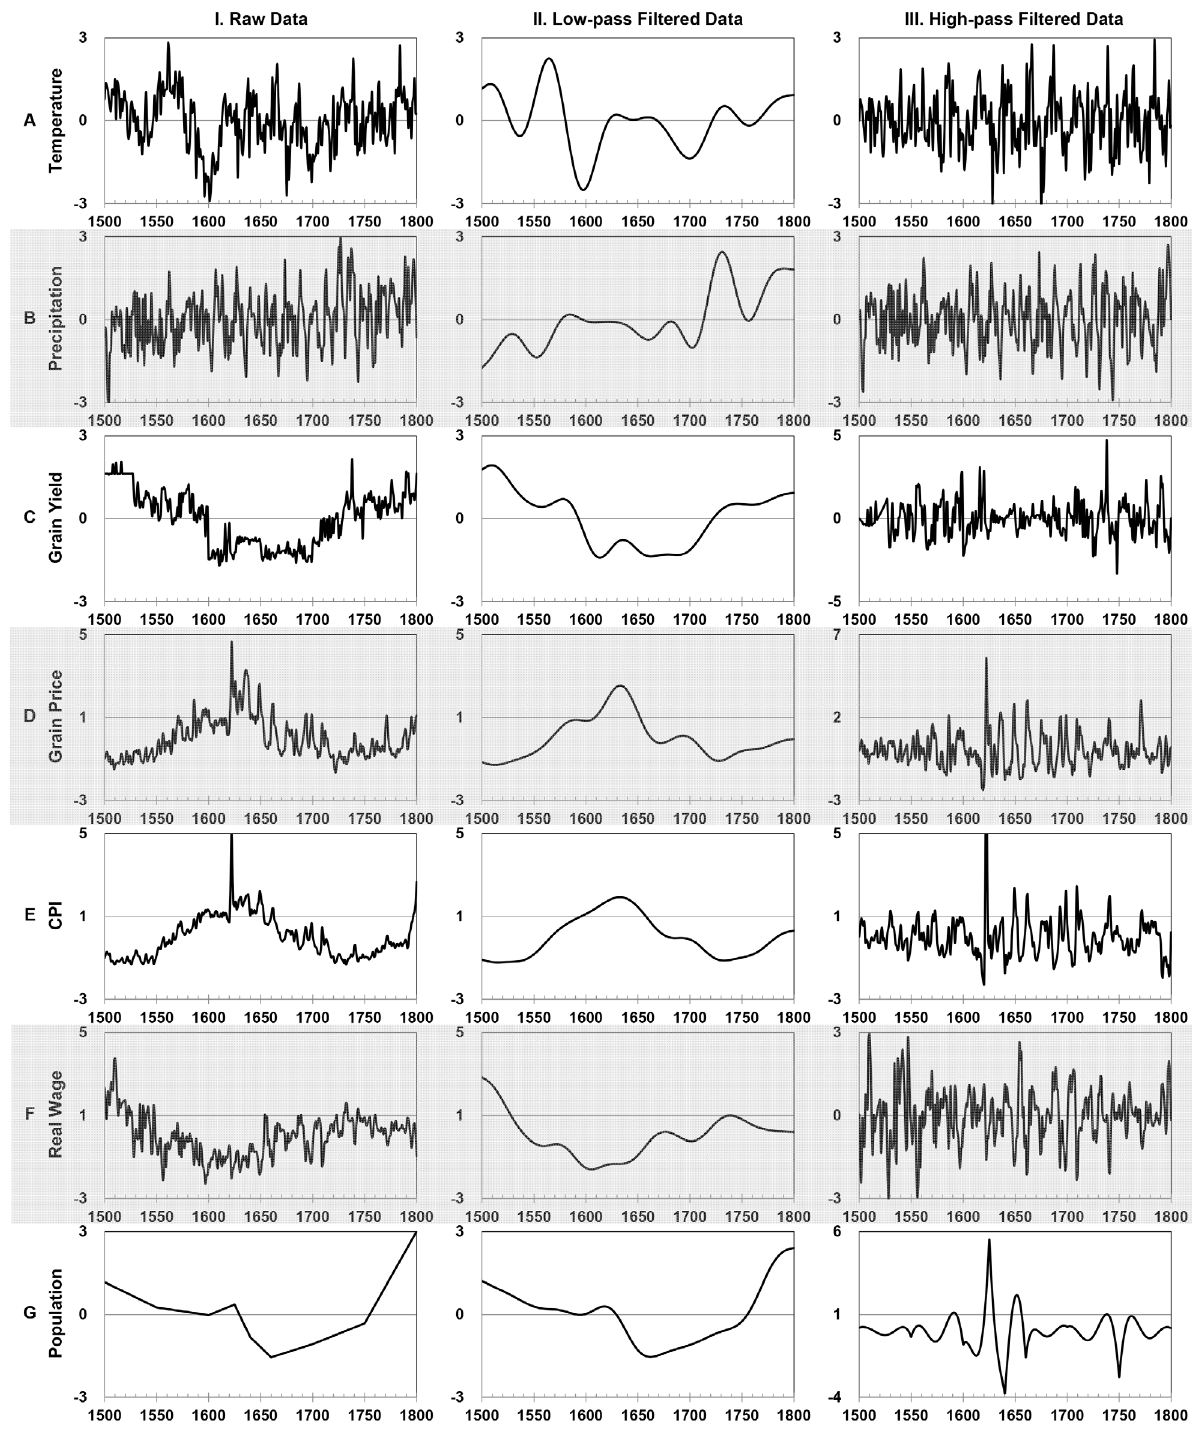
Figure 2. Visualization of the Causal Linkages in the Conceptual Model of Raw, Low-Pass Filtered, and High-Pass Filtered Data. Note: Column I represents raw data; Column II represents low-pass filtered data; and Column III represents high-pass filtered data. Row (a) represents Temperature; (b) Precipitation; (c) Grain Yield; (d) Grain Price; (e) CPI; (f) Real Wage; and (g) Population. Variables with obvious long-term trends, such as grain price, CPI, real wage, and population size, were linearly detrended. All data have been